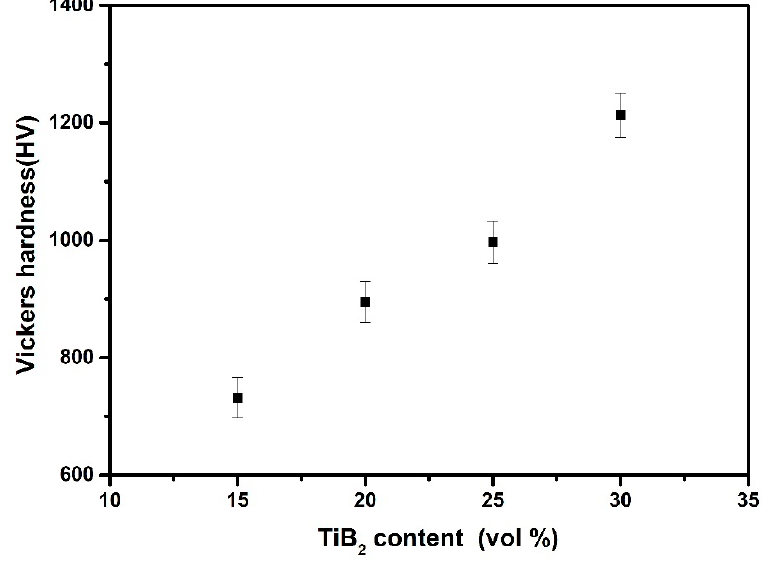
Figure 9. Variation of Vickers hardness of TiB 2 /Fe-15Cr-10Mn-5Al composites with TiB 2